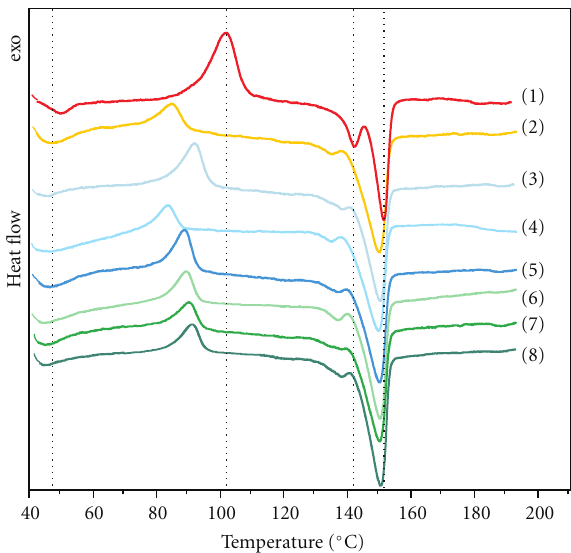
F 9: DSC curves of neat PLA and PLA-based samples.